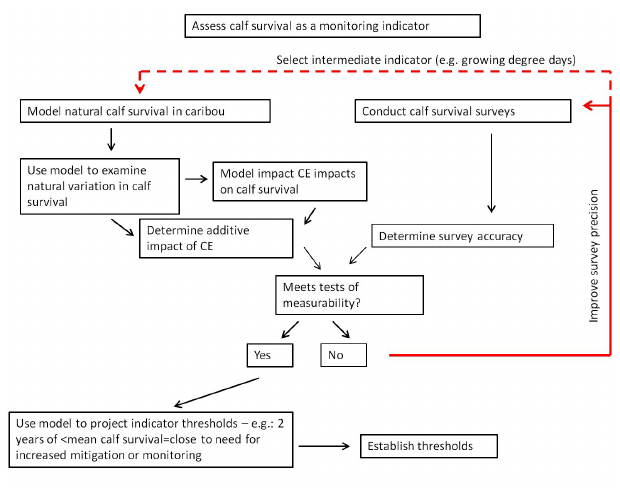
Fig. 3. Flow chart illustrating an approach to selecting indicators for measurement endpoints.